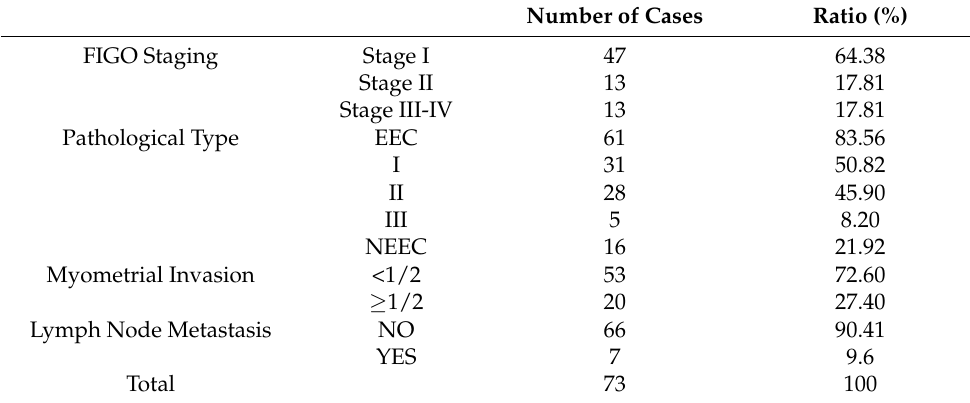
Table 1. Histopathological results of patients with